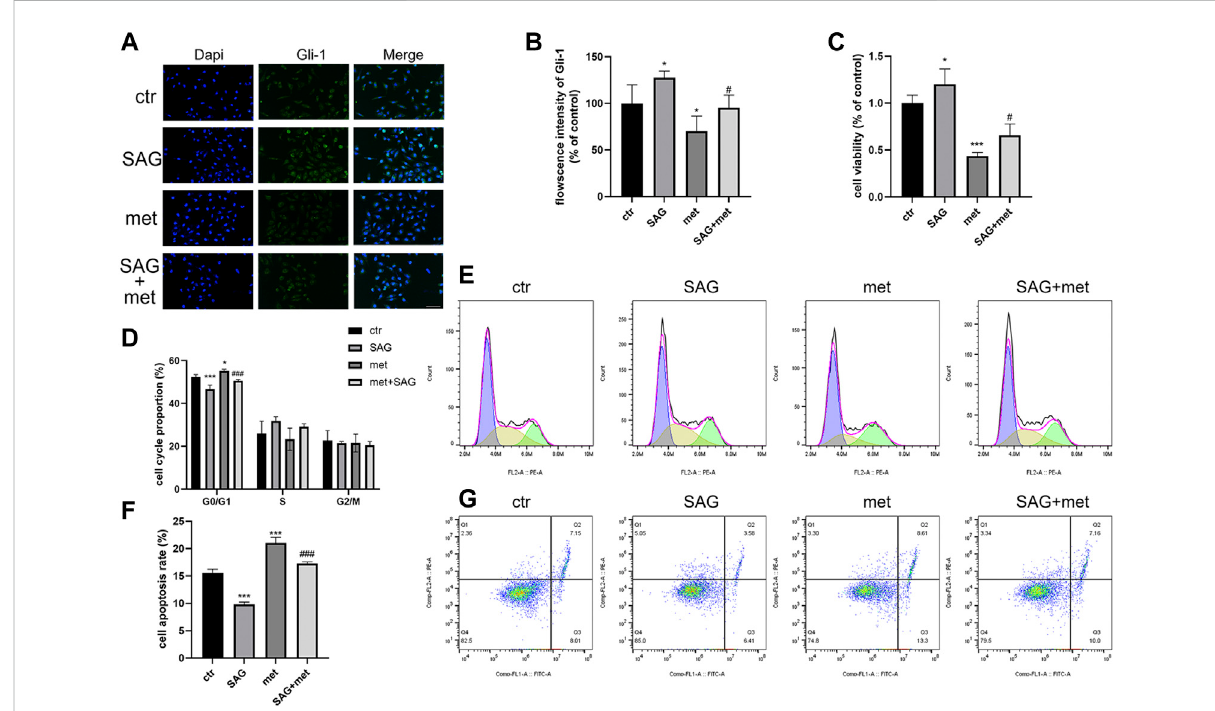
FIGURE 6 Metformin exerted antitumor effect on Daoy cells through the Shh signaling pathway. (A,B) The cells were treated with SAG (100 nm) for and metformin(3 mm)for24 handassessedbyimmuno fl uorescenceassaywithananti-Gli-1antibody(scalebar,50 μ m). (C) Thecellsweretreatedwith SAG (100 nm) and metformin (3 mm) for 24 h, and the viability of cells were tested by CCK-8 assay. (D – G) Flow cytometry was used to analyze apoptosisandcell cycledistributiononDaoycellsafter SAG(100 nm)for andmetformin(3 mm)for24 h.Data arepresentedas themean±SD, one-way ANOVA multiple comparisons were used to determine the signi fi cance. * p < 0.05; ** p < 0.01; *** p < 0.001 compared with the control group. # p < 0.05; ## p < 0.01; ### p < 0.001 compared with the met group.